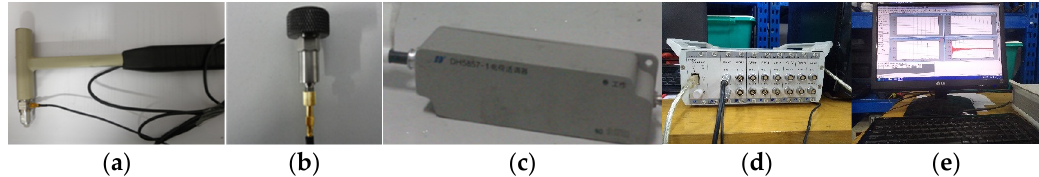
Figure 6. The first six mode shapes for SSSS-F FGMs square plate with central circular cutout ( h/a = 0.2, p = 1 ) .